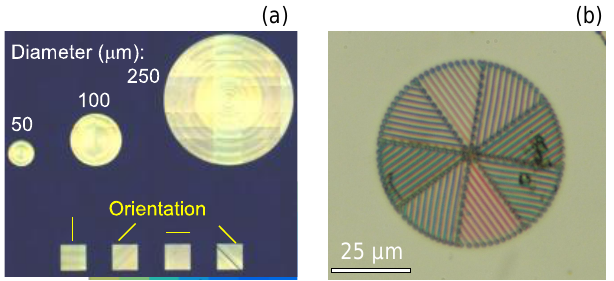
Figure A3. ( a ) Optical microscope image of circular and 1D gratings milled in 100-nm-thick Au on micro-thin (30 µ m) sapphire. The smallest circular grating was used in measurement shown in Figure 1. ( b ) A closeup optical image of the q-plate used for measurements shown in Figure